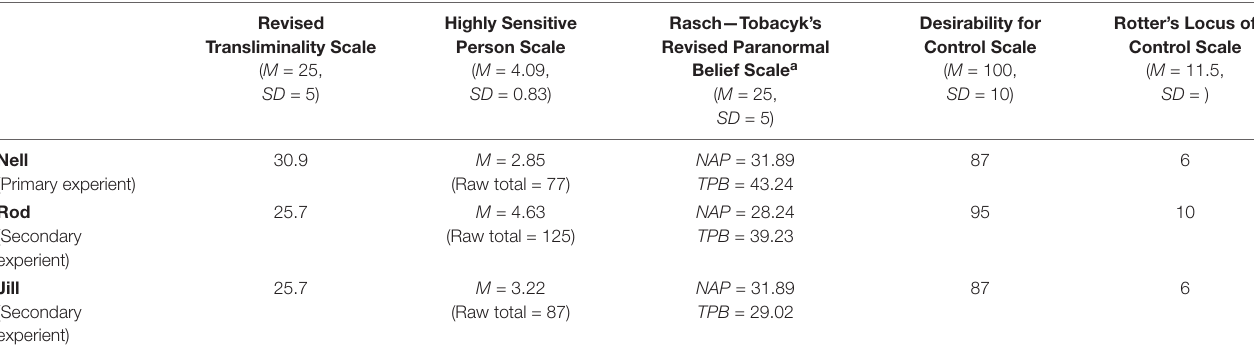
TABLE 3 | Perceptual-personality profiles of the afflicted family